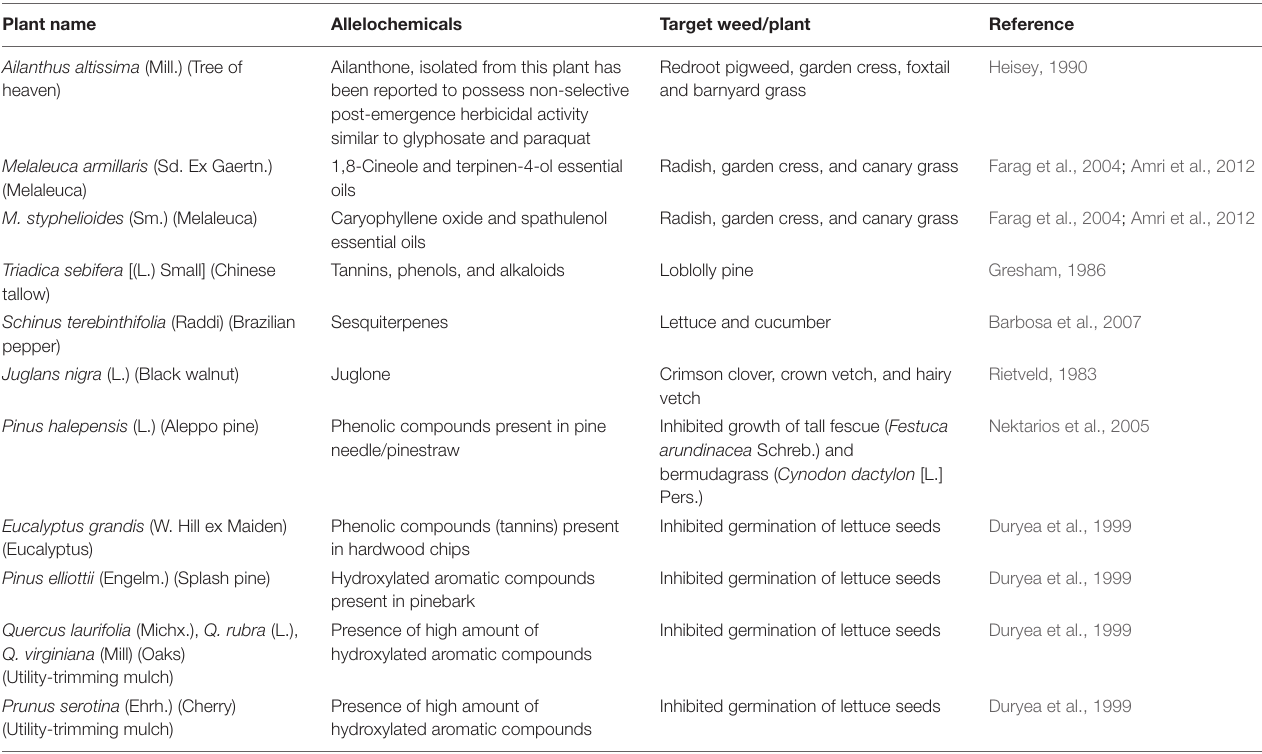
TABLE 2 | Allelopathic properties of common and potential mulch